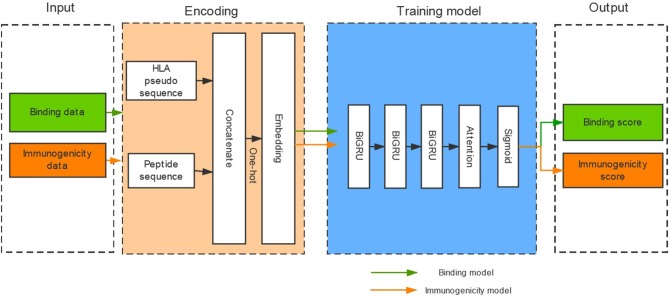
The architecture of DeepHLApan. Two types of data (437,077 binding data points, 32,785 immunogenicity data points) are collected for model training, and one-hot encoding is used for amino acid representation. Three layers of bidirectional GRU with attention have been employed as the model framework. The immunogenic score is used as a filter (>0.5), and peptides with binding scores ranked within the top 20 are predicted as high-confidence neoantigens.